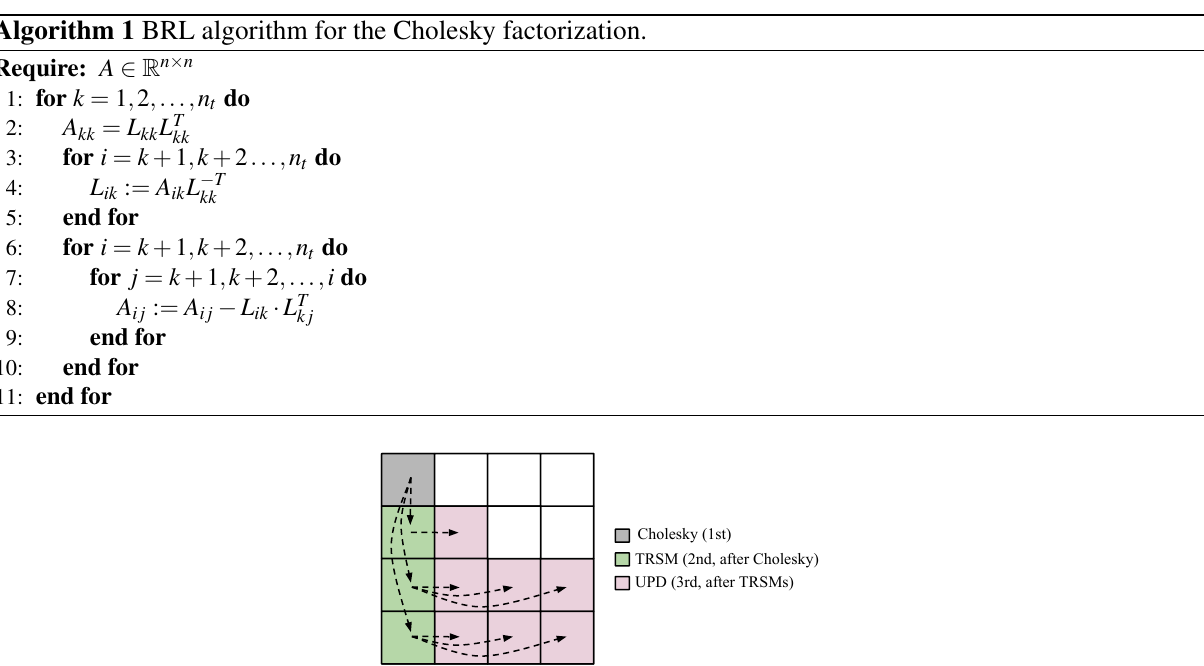
Fig. 3 Operations and data dependencies in the first iteration ( k = 1) of the BRL algorithm for the Cholesky factorization. the solution of the n t − 1 lower triangular systems for L i , 1 , i = 2 , 3 ,..., n t , during the first iteration of the BRL algorithm, can be obtained in any order, as these operations are independent from each